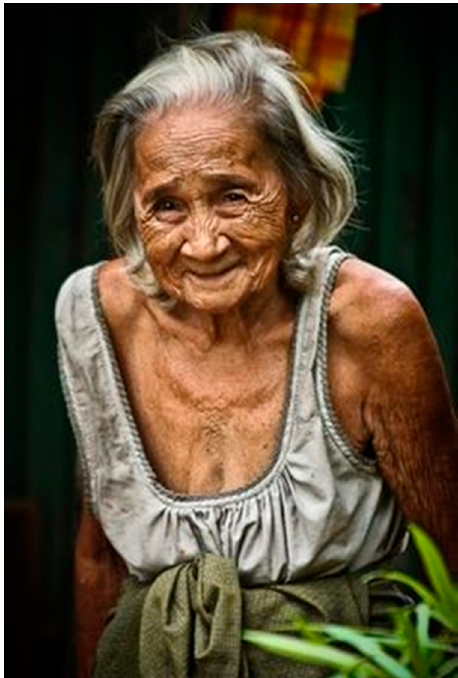
Figure 6. Aged skin.